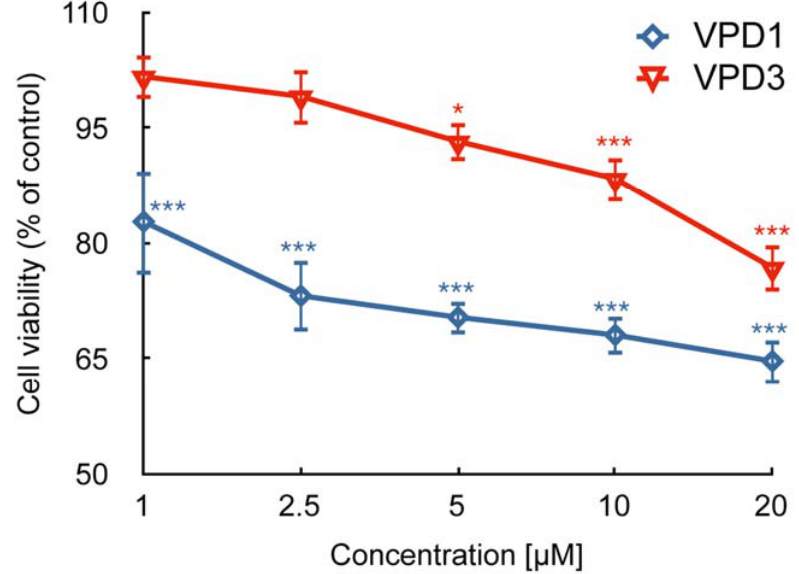
Figure 2. Cell viability of mHippoE-18 cells after 24 h treatment with VPDs (n = 5, * p < 0.05, ** p < 0.01, *** p < 0.001). Statistical differences occur for VPD1 between concentrations 1 and 2.5–20 μ M, 2.5 and 20 μ M, and for VPD3 between 1 and 5–20 μ M, 2.5 and 10–20 μ